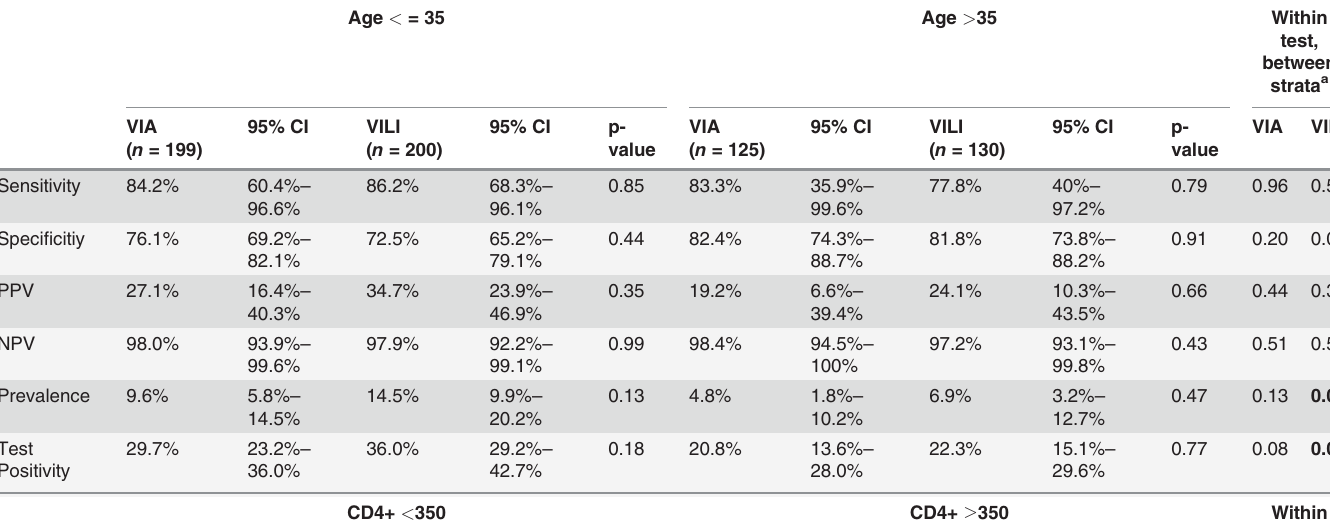
Table 3. Clinical performance of VIA or VILI for detection of CIN2+, stratified by age, CD4+ count, and HAART use. Age < = 35 Age > 35 Within